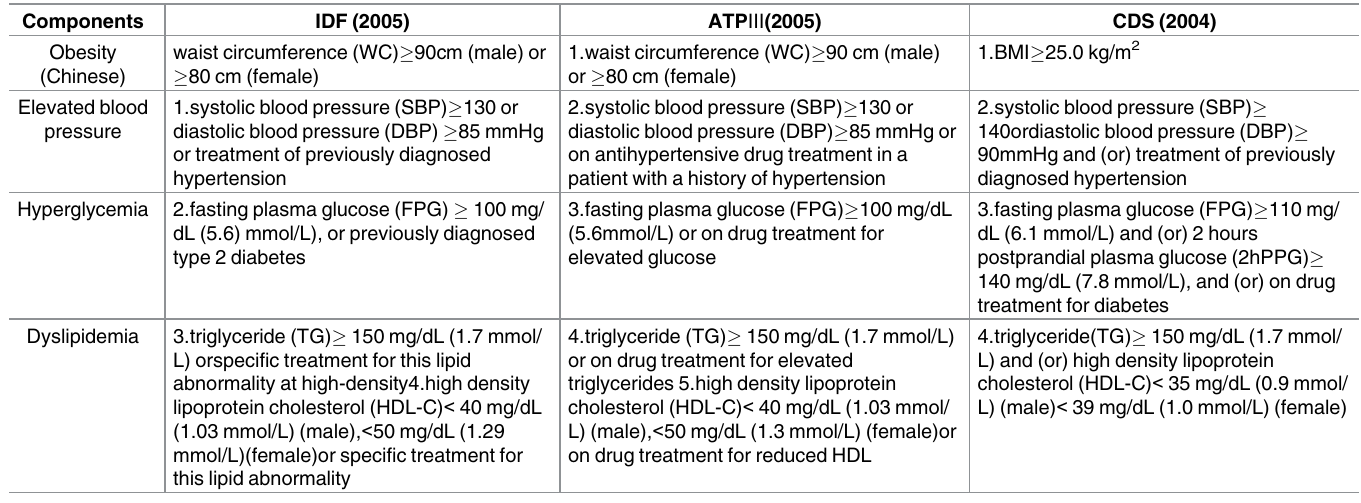
Table 1. The three criteria for